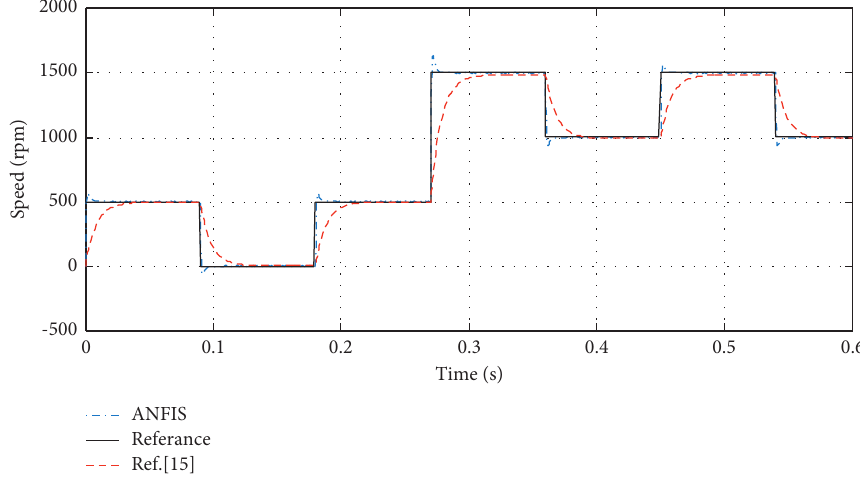
Figure 20: PMSM speed control with our proposed method and reference method [15].